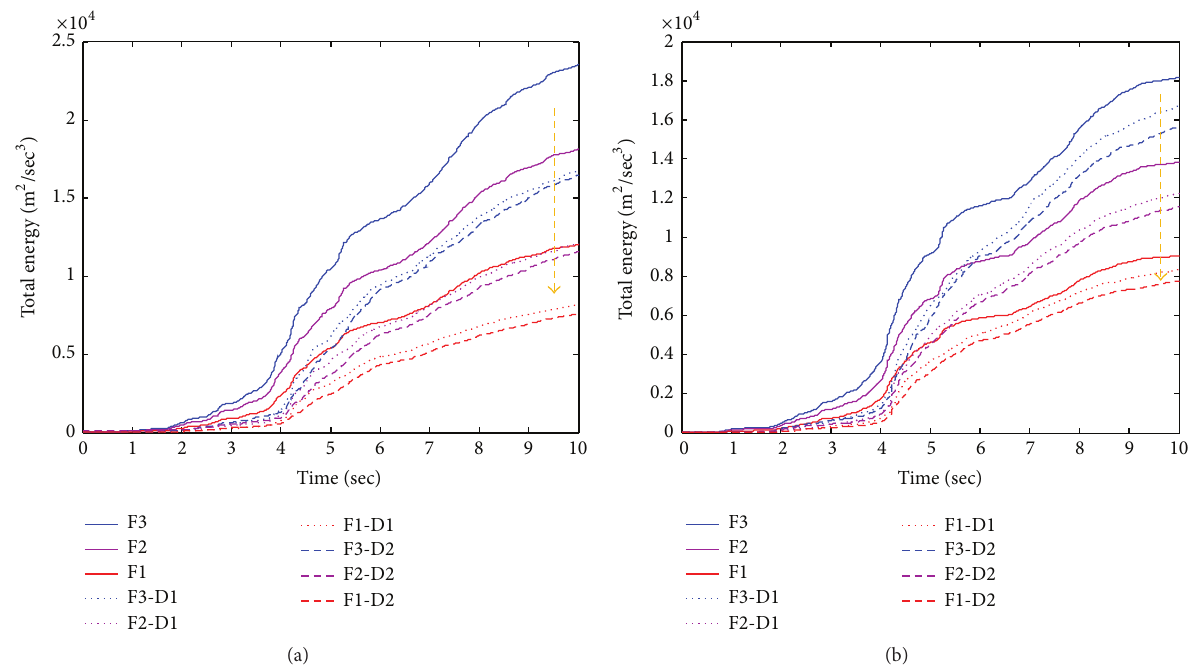
Figure 8: Total energy of (a) regular and (b) irregular buildings during damage cases D1 and